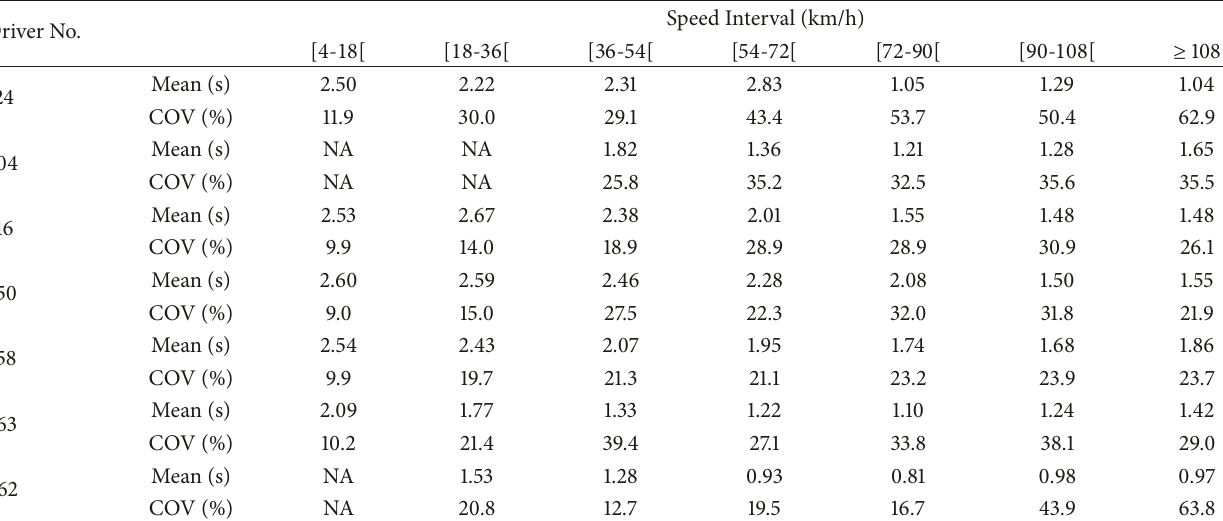
Table 2: Mean and COV for all drivers for all speed intervals.